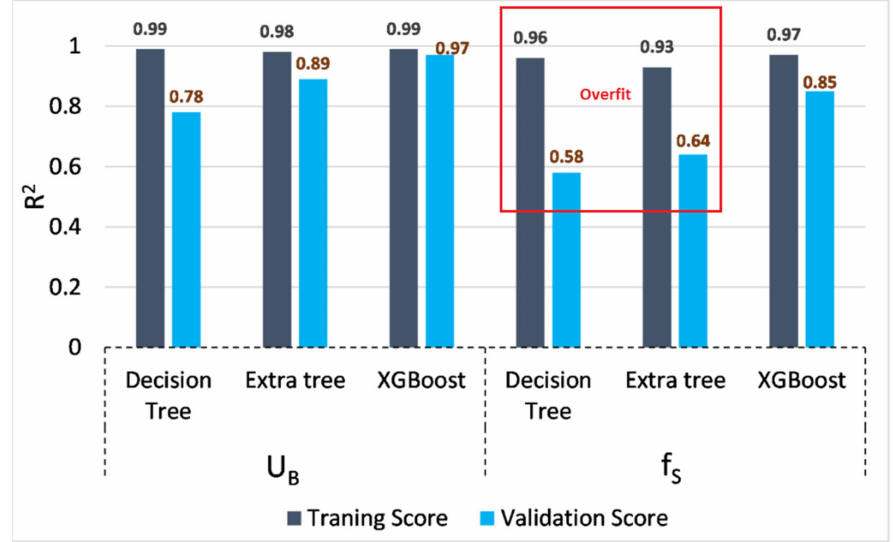
Figure 10. Training and validation accuracy of ML models (optimized using